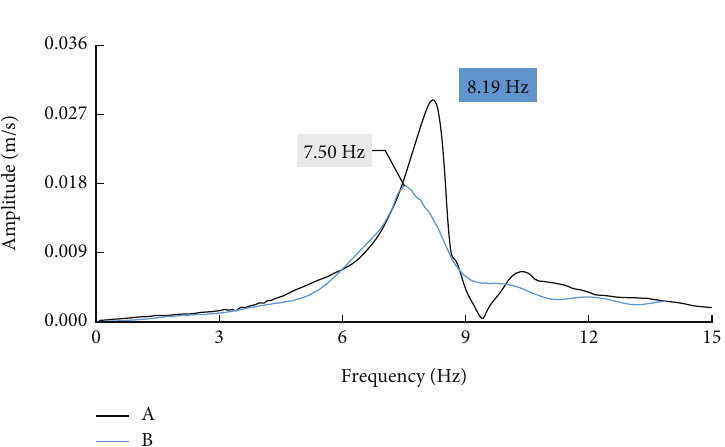
Figure 7: Results of the second monitoring.